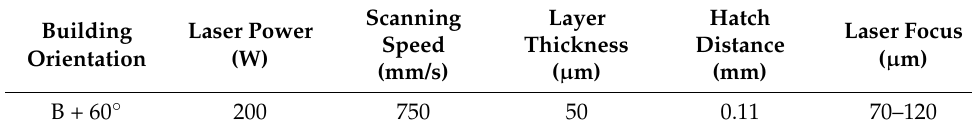
Table 2. LPBF process parameters